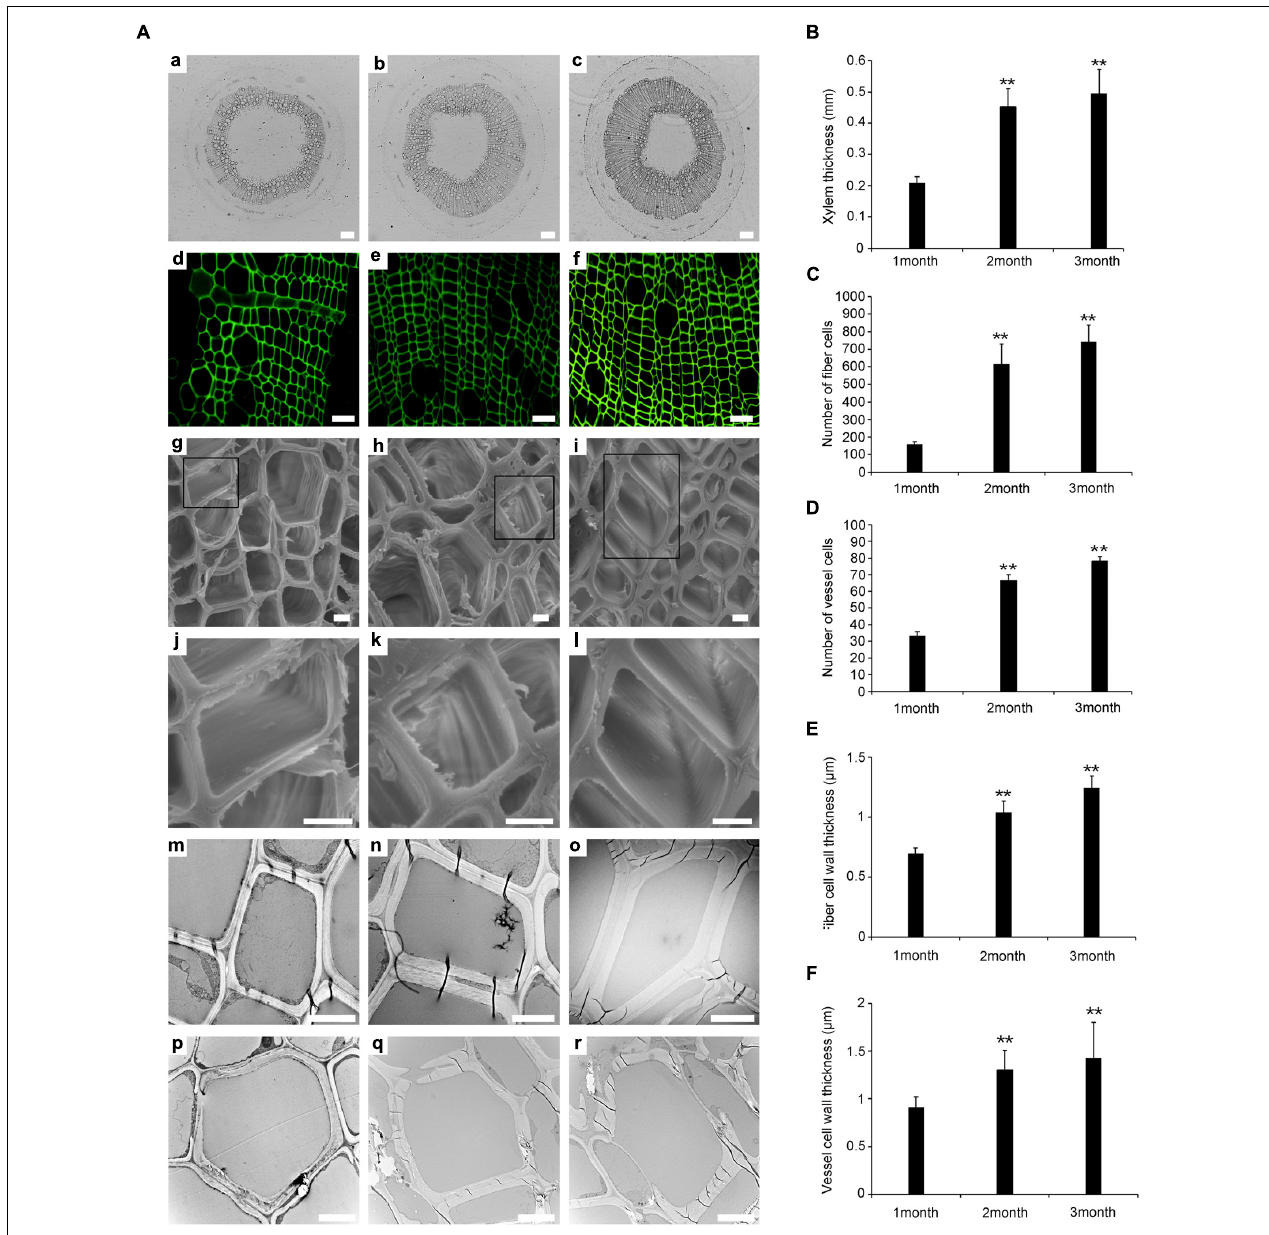
FIGURE 1 | Change in stem xylem development in P. tomentosa . (A) Paraffin section ( a–c , scale bar = 200 µ m), confocal laser scanning microscope images ( d–f , scale bar = 50 µ m), scanning electron micrographs ( g–l , scale bar = 5 µ m), and transmission electron micrographs ( m–r , scale bar = 5 µ m) of stem transverse sections at the three developmental stages. (a,d,g,j,m,p) The fourth internode of 1-month-old plants. (b,e,h,k,n,q) The fourth internode of stage of 2-month-old plants. (c,f,i,l,o,r) The fourth internode of 3-month-old plants. (j,k,l) Are enlarged view of (g,h,i) , respectively. (B) Xylem thickness of the fourth internode from the base upward in the three developmental stages. (C) The number of fiber cells of the fourth internode. (D) The number of vessel cells of the fourth internode. (E) Fiber cell wall thickness of the fourth internode. (F) Vessel cell wall thickness of the fourth internode. The data are means ± SD ( n = 60). ** P <